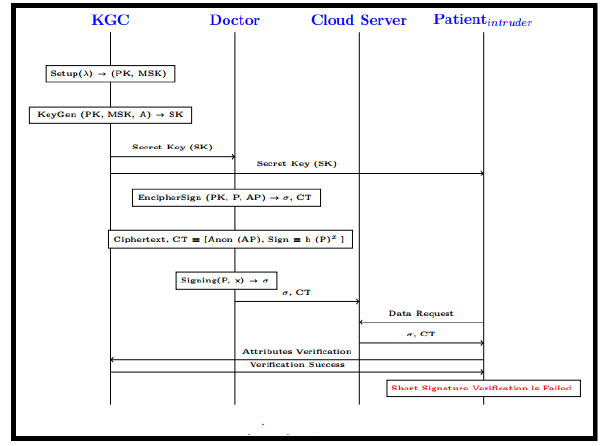
Figure 18. Threat model—policy anonymization